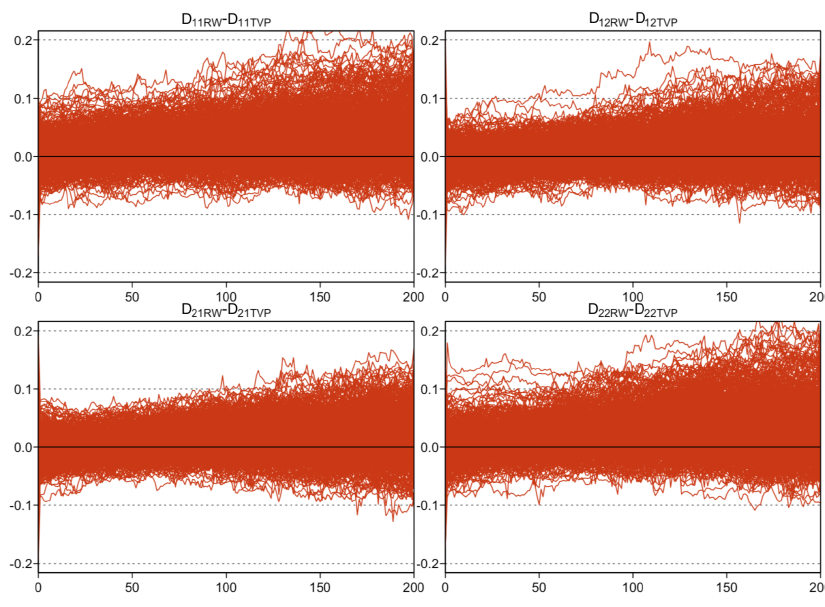
Figure 1. Monte Carlo simulation results with a single outlier.